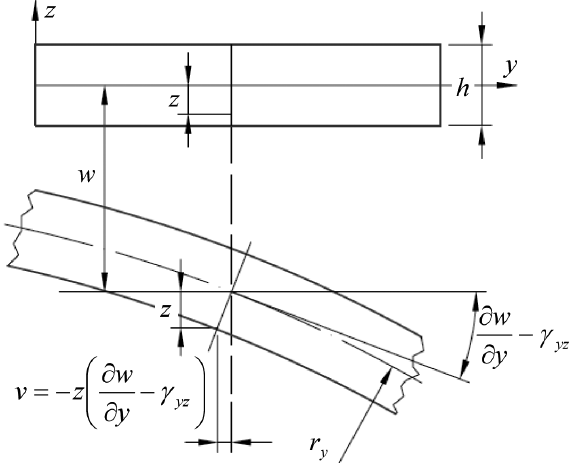
Fig. 1. Transverse shear